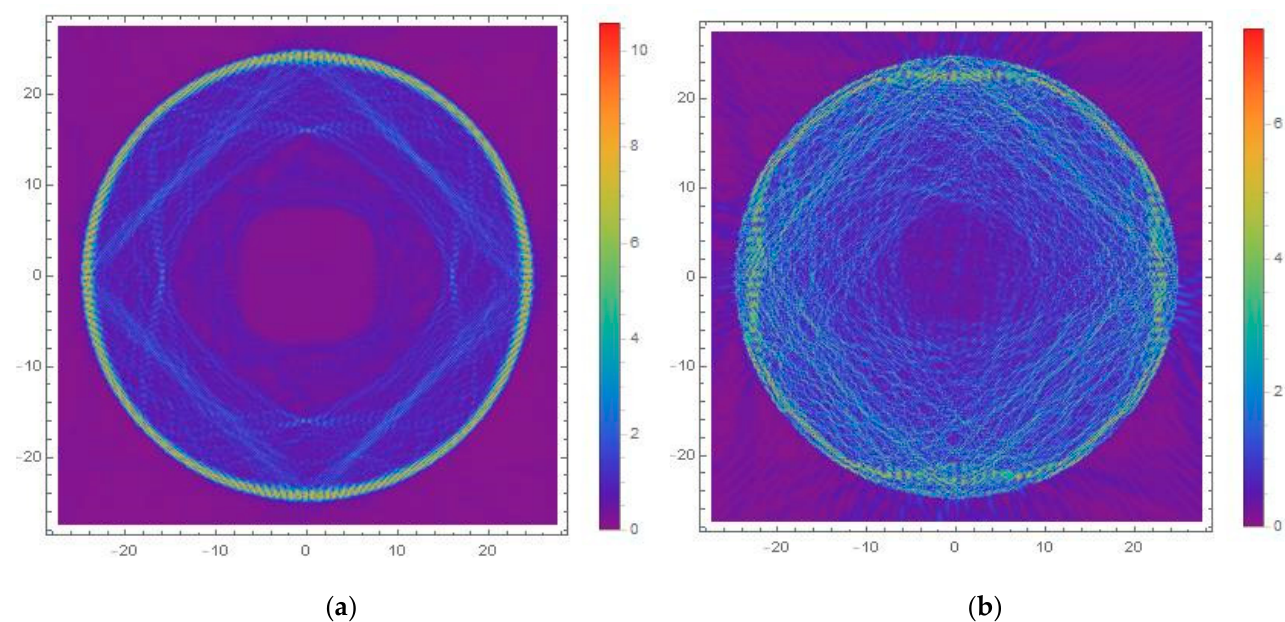
Figure 9. Numerical simulation results of the electric field strengths in the resonator at different roughness values: ( a ) σ = 1 nm; ( b ) σ = 40 nm.